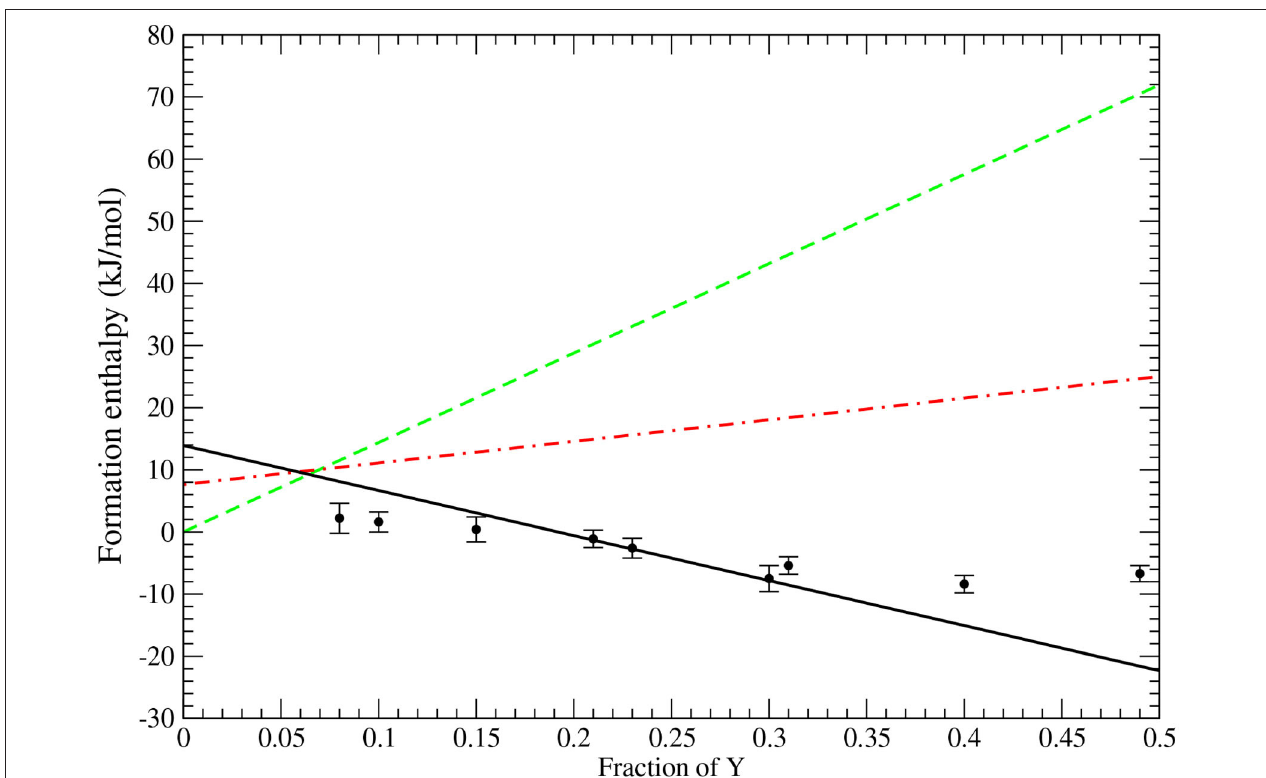
FIGURE 2 | The computed formation enthalpies of YO 1.5 − ZrO 2 system. The lines represent results for monoclinic (dashed green), trigonal (dot-dashed red), and cubic (solid black) phases. The data comes from Lee et al.